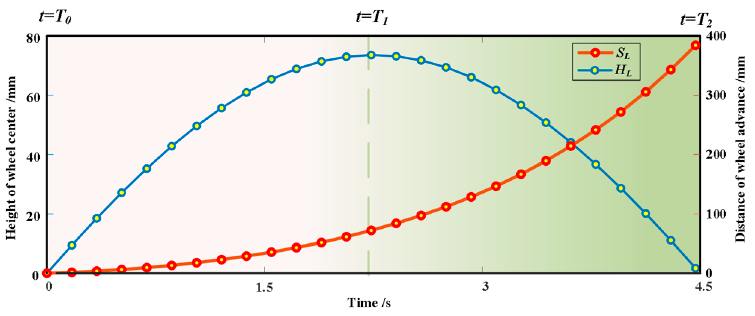
Figure 9. Wheel center height and forward distance as a function of time.